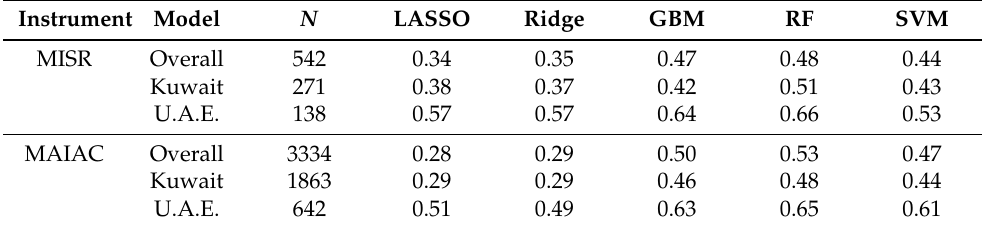
Table 1. Median test R 2 across machine learning methods, AOD sources, and